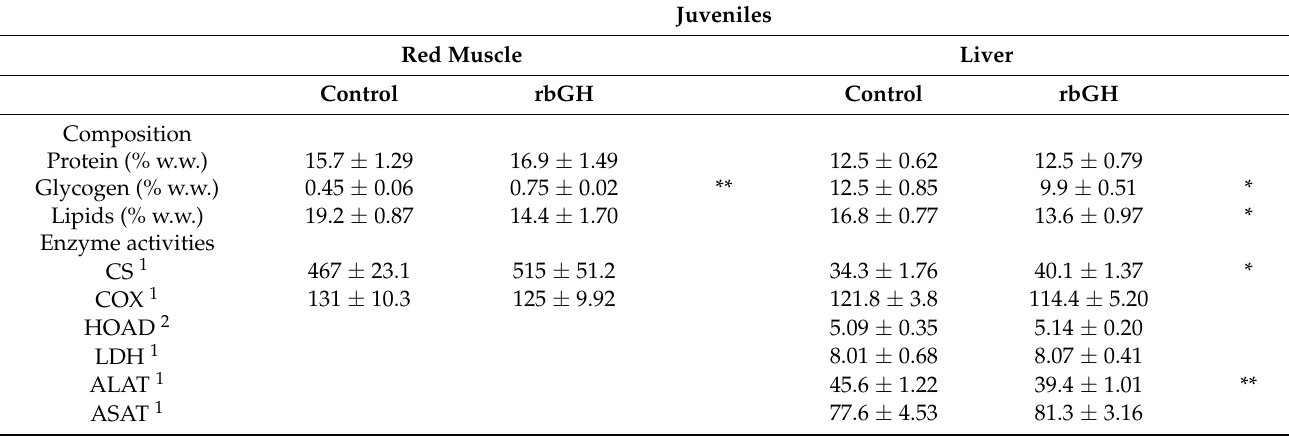
Table 3. Proximal composition and metabolic enzyme activities in red muscle and liver after 9 weeks of rBGH injection on gilthead sea bream juveniles.